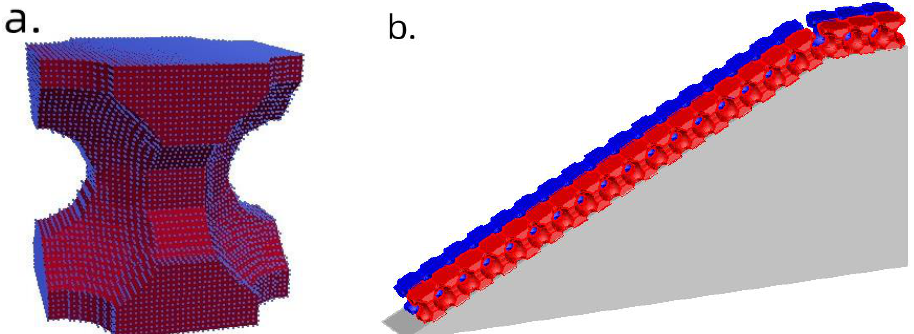
Figure 3. ( a ) Structure of the artificial block, TB-CUBE; ( b ) Artificial block on the breakwater in the numerical model (two blocks in the flume width direction).